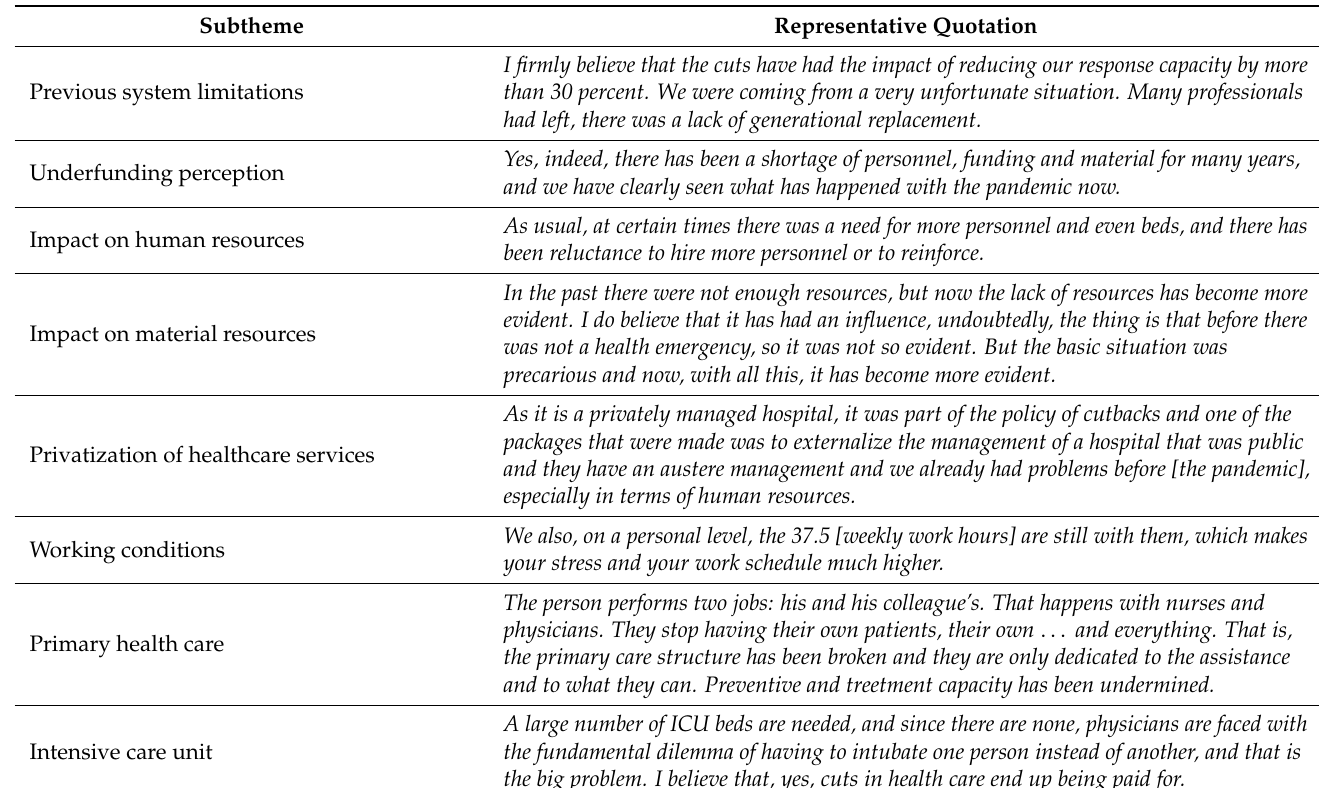
Table 3. Subthemes and representative quotations for the main theme “Impact of austerity measures on the management of the COVID-19